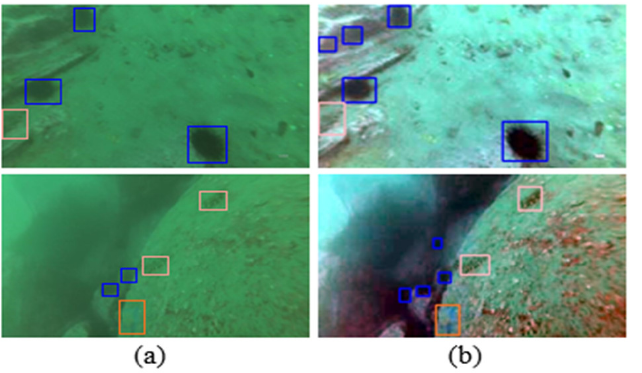
Figure 1. Marine object detection: ( a ) detection by YOLOV5; ( b ) detection by the proposed model.